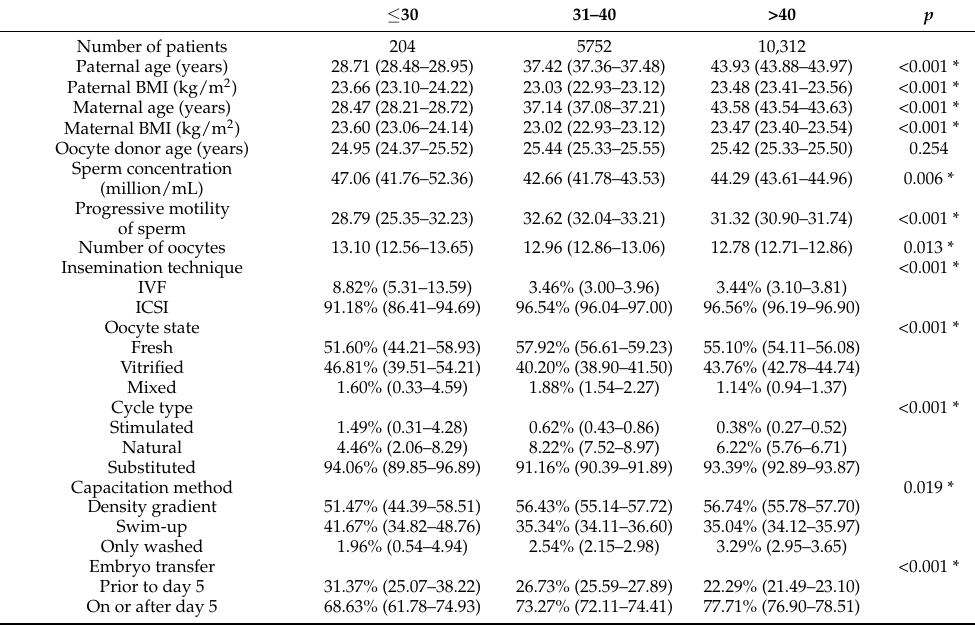
Table 1. Baseline characteristics and ART details of the study